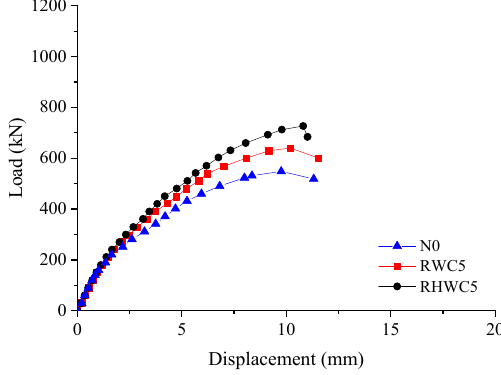
Figure 7. Load–deflection ( P– δ ) responses.